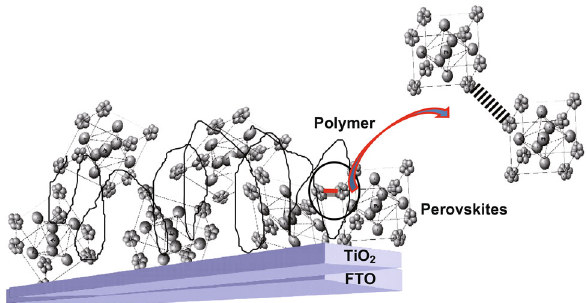
Fig. 16 Schematic view of the CH 3 NH 3 PbI 3 with ethyl